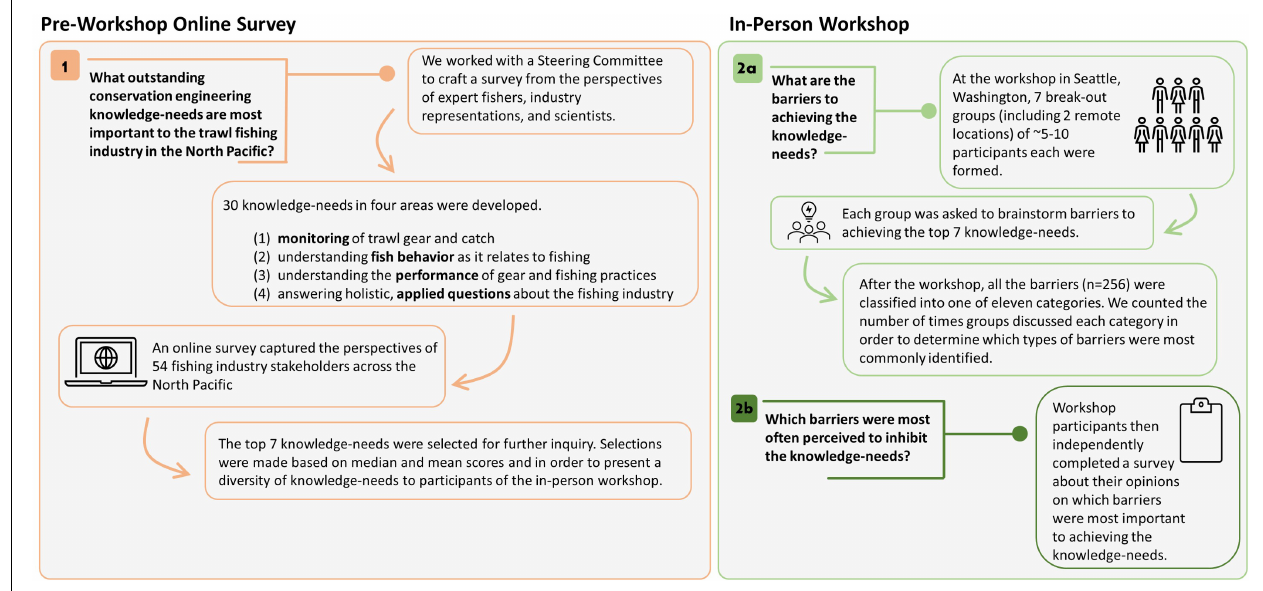
FIGURE 1 | Summary of primary study objectives and methods. The panel on the left represents methods used to generate a list of prioritized knowledge-needs using an online survey. The panel on the right represents methods used during the F.I.S.H. Workshop to collect information related to the barriers inhibiting progress in achieving top